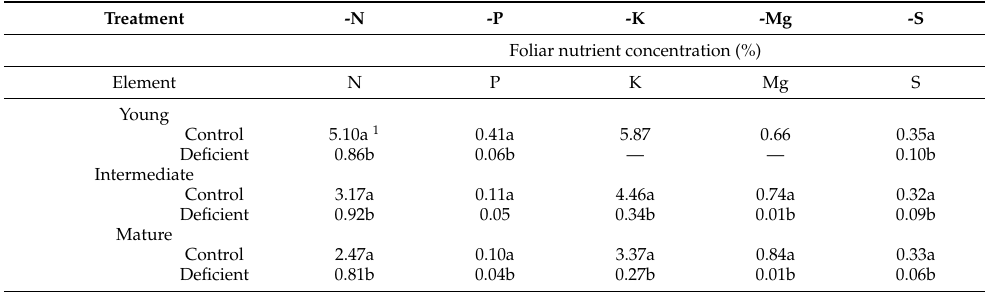
Table 1. Pairwise comparisons of foliar nutrient concentrations found in the most recently matured leaves of young, intermediate, and mature flue-cured tobacco ( Nicotiana tabacum L.) plants grown under macronutrient deficient